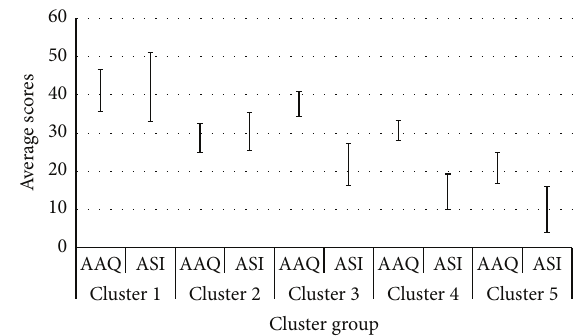
Figure 1: Two-step cluster subgroups based on Acceptance and Action Questionnaire and Anxiety Sensitivity Index. Note : AAQ: Acceptance to Action Questionnaire; ASI: Anxiety Sensitivity Index